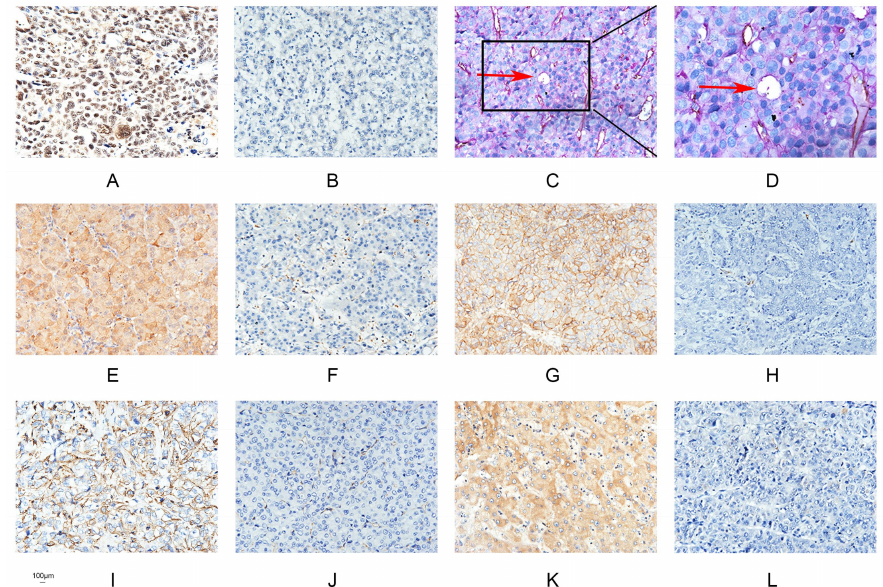
Figure 1. Hepatocellular carcinoma specimens were analyzed by immunohistochemistry. ( A ) Runx2 was predominantly localized in the nuclear of cancer cells ( × 200; bars 100 µ m); ( B ) Negative expression of Runx2 ( × 200; bars 100 µ m); ( C ) CD31/PAS double staining displayed VM channels (Red arrow) in Hepatocellular carcinoma specimens ( × 200; bars 100 µ m); ( D ) VM channels (Red arrow)( × 400; bars 100 µ m); ( E ) Nuclear and cytoplasmic staining of Galectin-3 ( × 200; bars 100 µ m); ( F ) Negative expression of Galectin-3 ( × 200; bars 100 µ m); ( G ) Positive E-cadherin expression ( × 200; bars 100 µ m); ( H ) Negative E-cadherin expression ( × 200; bars 100 µ m); ( I ) Positive Vimentin expression ( × 200; bars 100 µ m); ( J ) Negative Vimentin expression ( × 200; bars 100 µ m); ( K ) Positive VE-cadherin expression ( × 200; bars 100 µ m); ( L ) Negative VE-cadherin expression ( × 200; bars 100 µ